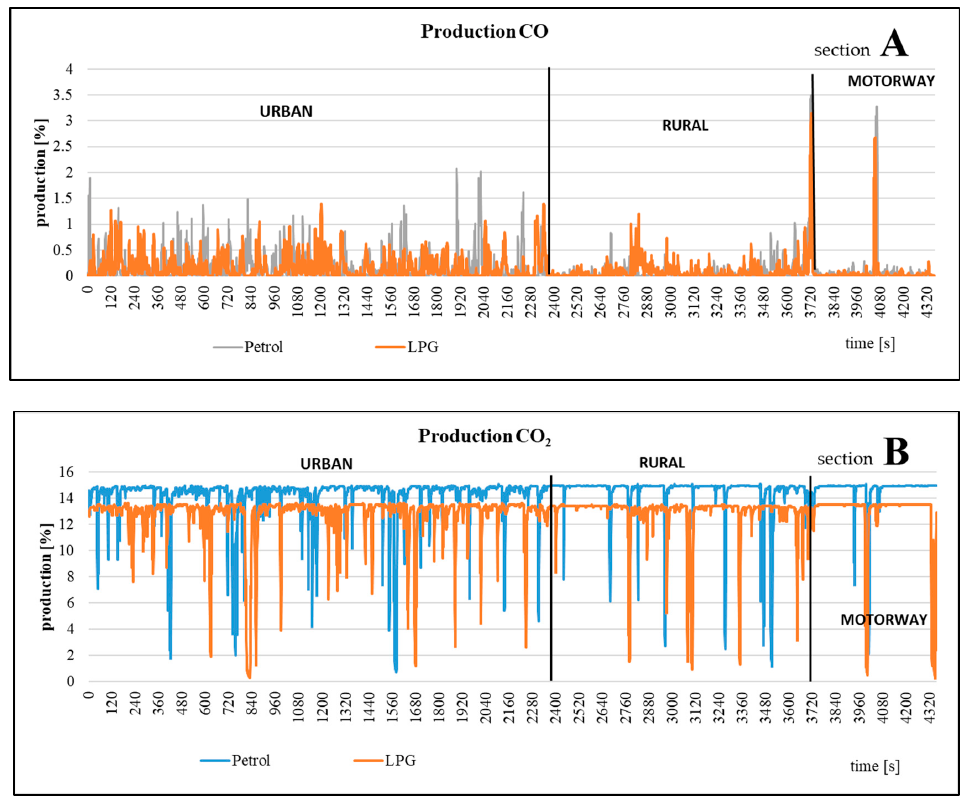
Figure 8. CO ( A ) and CO 2 ( B ) production during driving [author]. When monitoring CO production (section A), it is possible to state that the curves have an almost identical course, but the curve representing LPG combustion is located lower than the combustion curve of gasoline. The same is true when monitoring CO 2 pro ‐ duction (section B). The waveforms of the individual curves are identical, but the curve representing LPG combustion reaches a lower value in each monitored section of the measuring path. Figure 9 shows the lambda factor for both fuels. Since the emission measurement is in the form of a volume concentration, it cannot be deduced from the percentage of CO 2 during the measurement of a higher CO 2 concentration in%, which means a higher pro ‐ duction in grams. The LPG vehicle was operated at a significantly higher fuel surplus